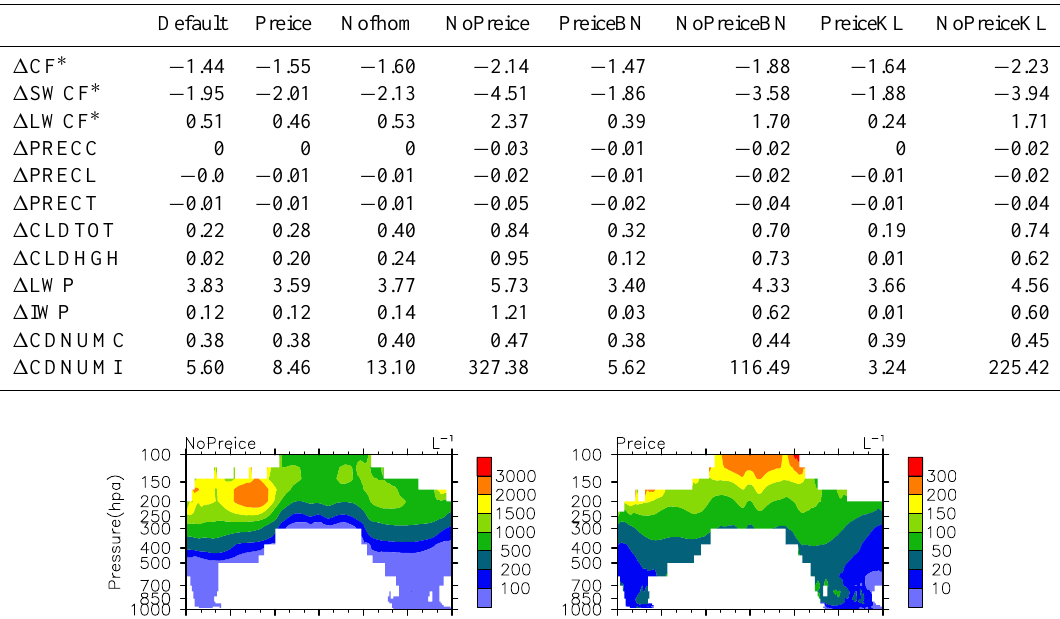
Table 3. Global annual mean variable changes (present-day minus pre-industrial times). Illustrated are changes in net cloud forcing ( (cid:49) CF ∗ , Wm − 2 ) as well as the long-wave ( (cid:49) LWCF ∗ , Wm − 2 ) and shortwave ( (cid:49) SWCF ∗ , Wm − 2 ) components; the changes in convective ( (cid:49) PRECC, mmd − 1 ) , large-scale ( (cid:49) PRECL, mmd − 1 ) and total precipitation rate ( (cid:49) PRECT, mmd − 1 ) ; the change in total cloud fraction ( (cid:49) CLDTOT,%), high cloud fraction ( (cid:49) CLDHGH,%), liquid water path ( (cid:49) LWP, gm − 2 ) , ice water path ( (cid:49) IWP, gm − 2 ) ; and column droplet number concentration ( (cid:49) CDNUMC, 10 10 m − 2 ) and column ice number concentration ( (cid:49) CDNUMI, 10 6 m − 2 ) .